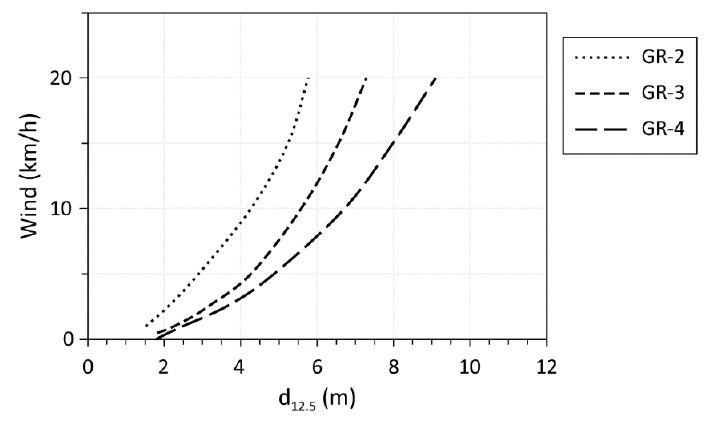
Figure 7. Safe separation distances as a function of wind speed at Low MC (D2L2) for GR fuel models.